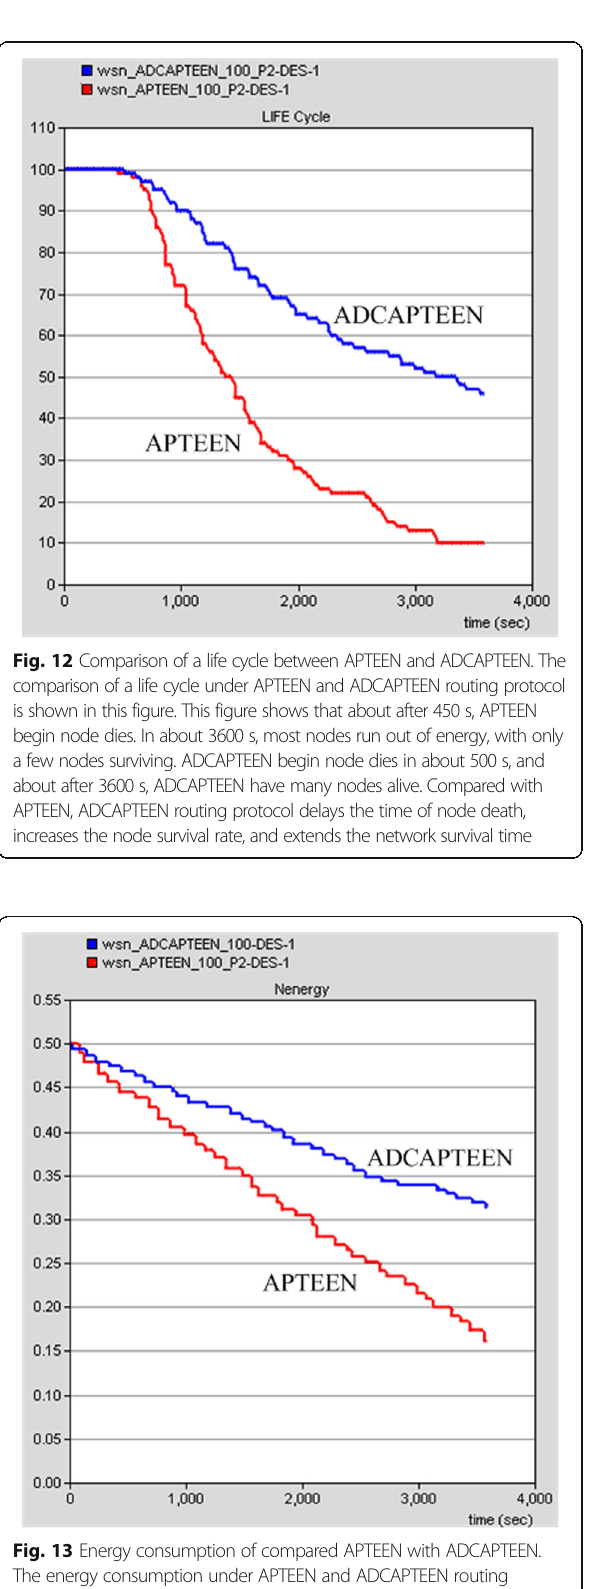
Fig. 13 Energy consumption of compared APTEEN with ADCAPTEEN.